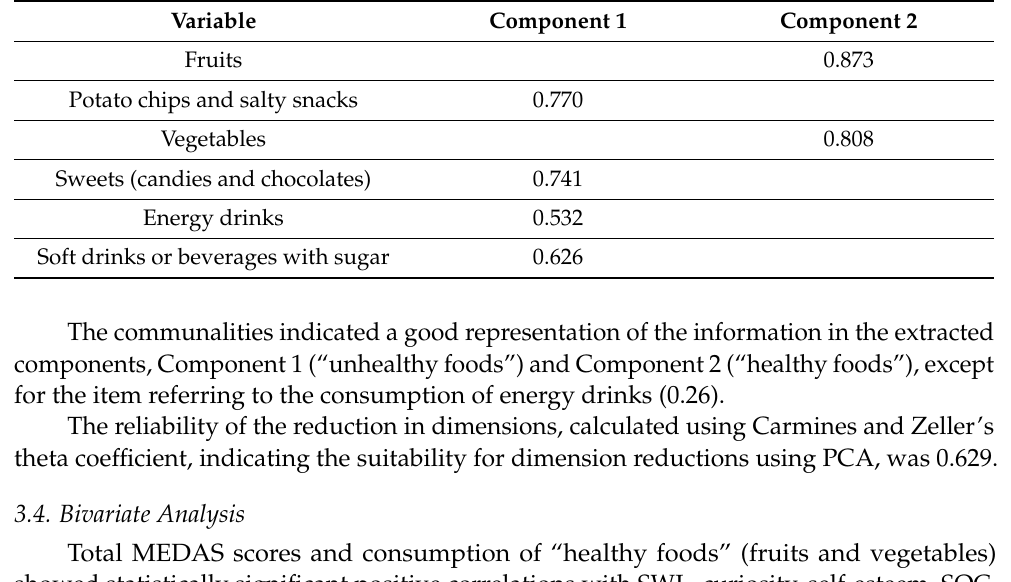
Table 3. Pattern matrix after Promax